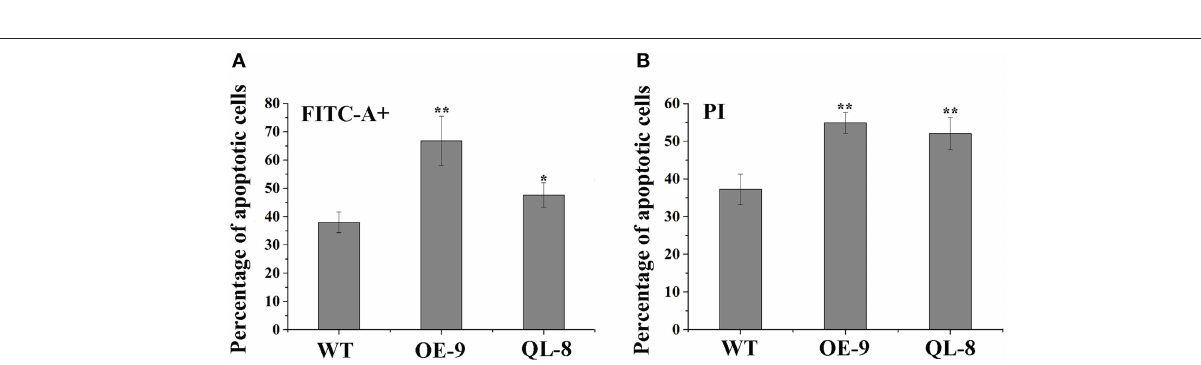
regulation-related NAC and MYB genes, such as SND1-A1 (ortholog of AtSND1 ), VND6-C1 ( AtVND6 ), MYB21 ( AtMYB46 and AtMYB83 ), MYB031 ( AtMYB69 ), MYB090 ( AtMYB52